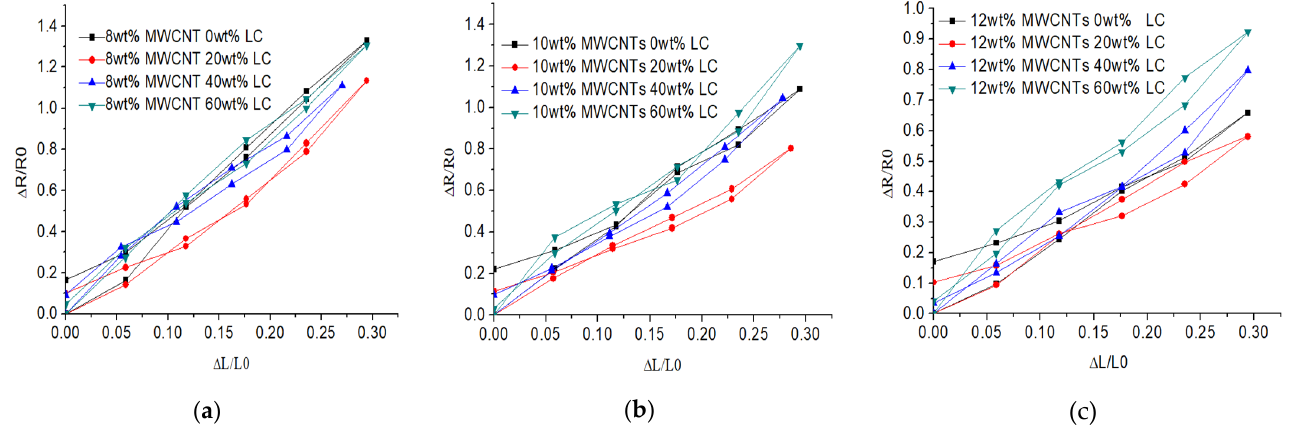
Figure 7. The hysteresis of the tensile sensing with 0–60 wt% LC and MWCNTs of ( a ) 8 wt%; ( b ) 10 wt%; and ( c ) 12 wt%.